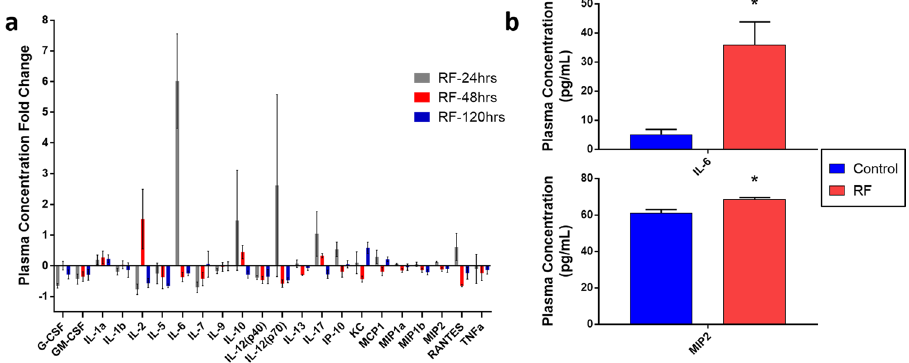
Figure 4. Blood plasma cytokine panel time-course analysis following single-dose RFT. At 24, 48, or 120 hrs after a single RFT blood plasma was analyzed for 25 cytokines. ( a ) Cytokine plasma concentration fold-change of RF-treated mice at 24, 48, or 120 hours post-RFT compared to control mice. Fold changes for each analyte were calculated by taking the ratio of average plasma concentrations of RFT-mice and control mice for each independent time-point (i.e. [G-CSF] 24 hr RF /[G-CSF] 24 hr Control ) (n = 5/group). ( b ) Plasma concentration in pg/ mL of IL-6 (top) and MIP2 (bottom) comparing control and RF-treated mice 24hrs post-RFT (n = 5/group). Error bars represent SEM. ( * p <